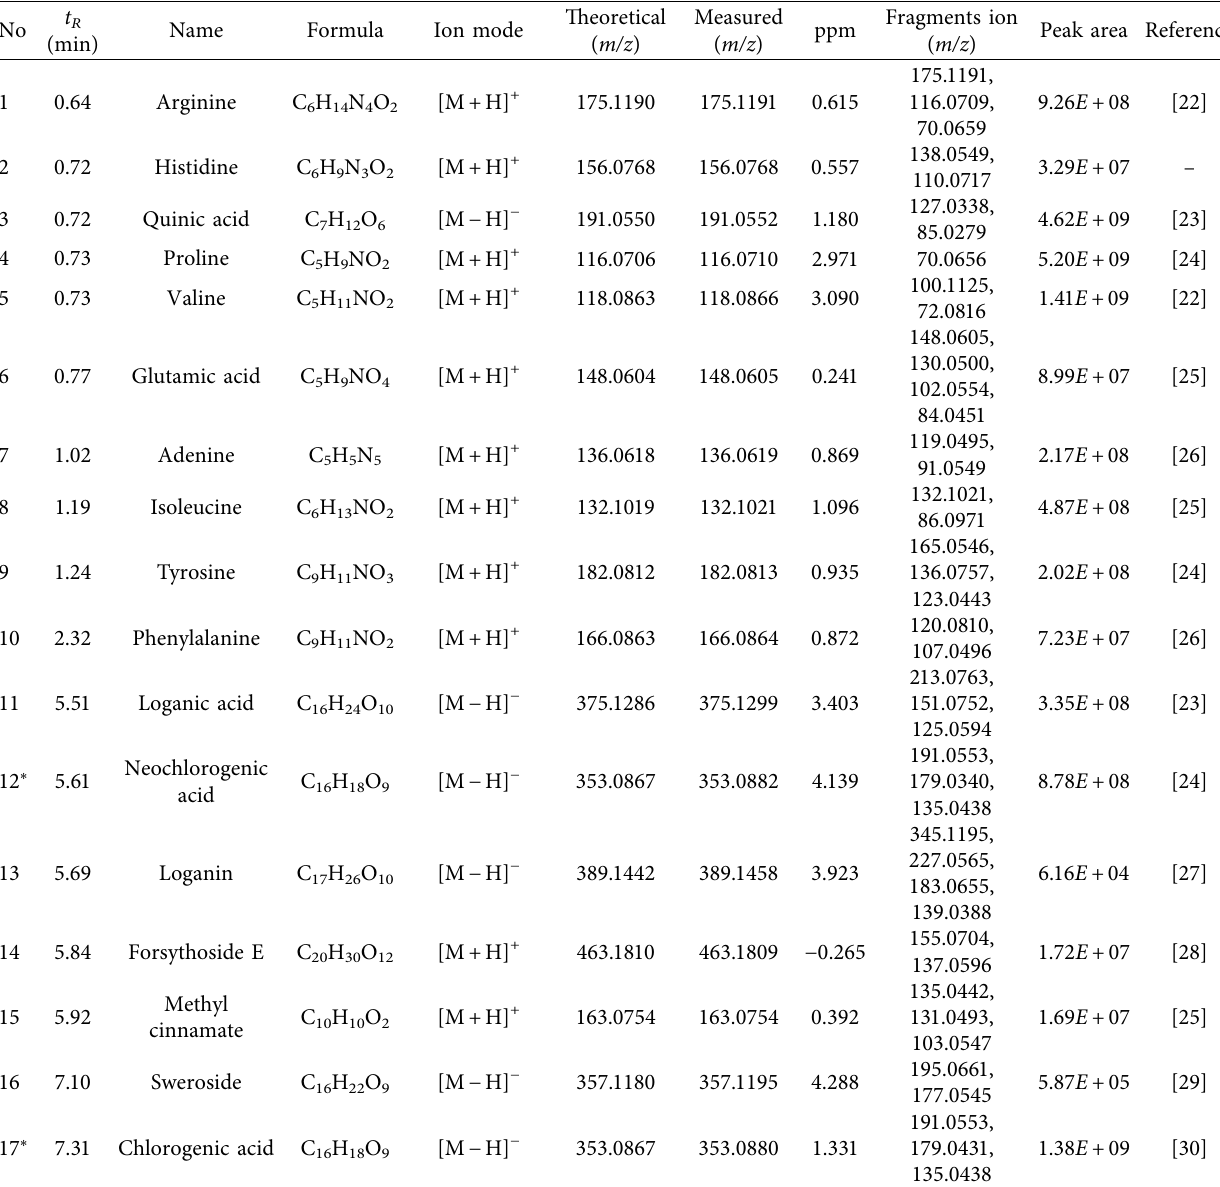
Table 3: Information of identifed compounds in Yinqiao powder